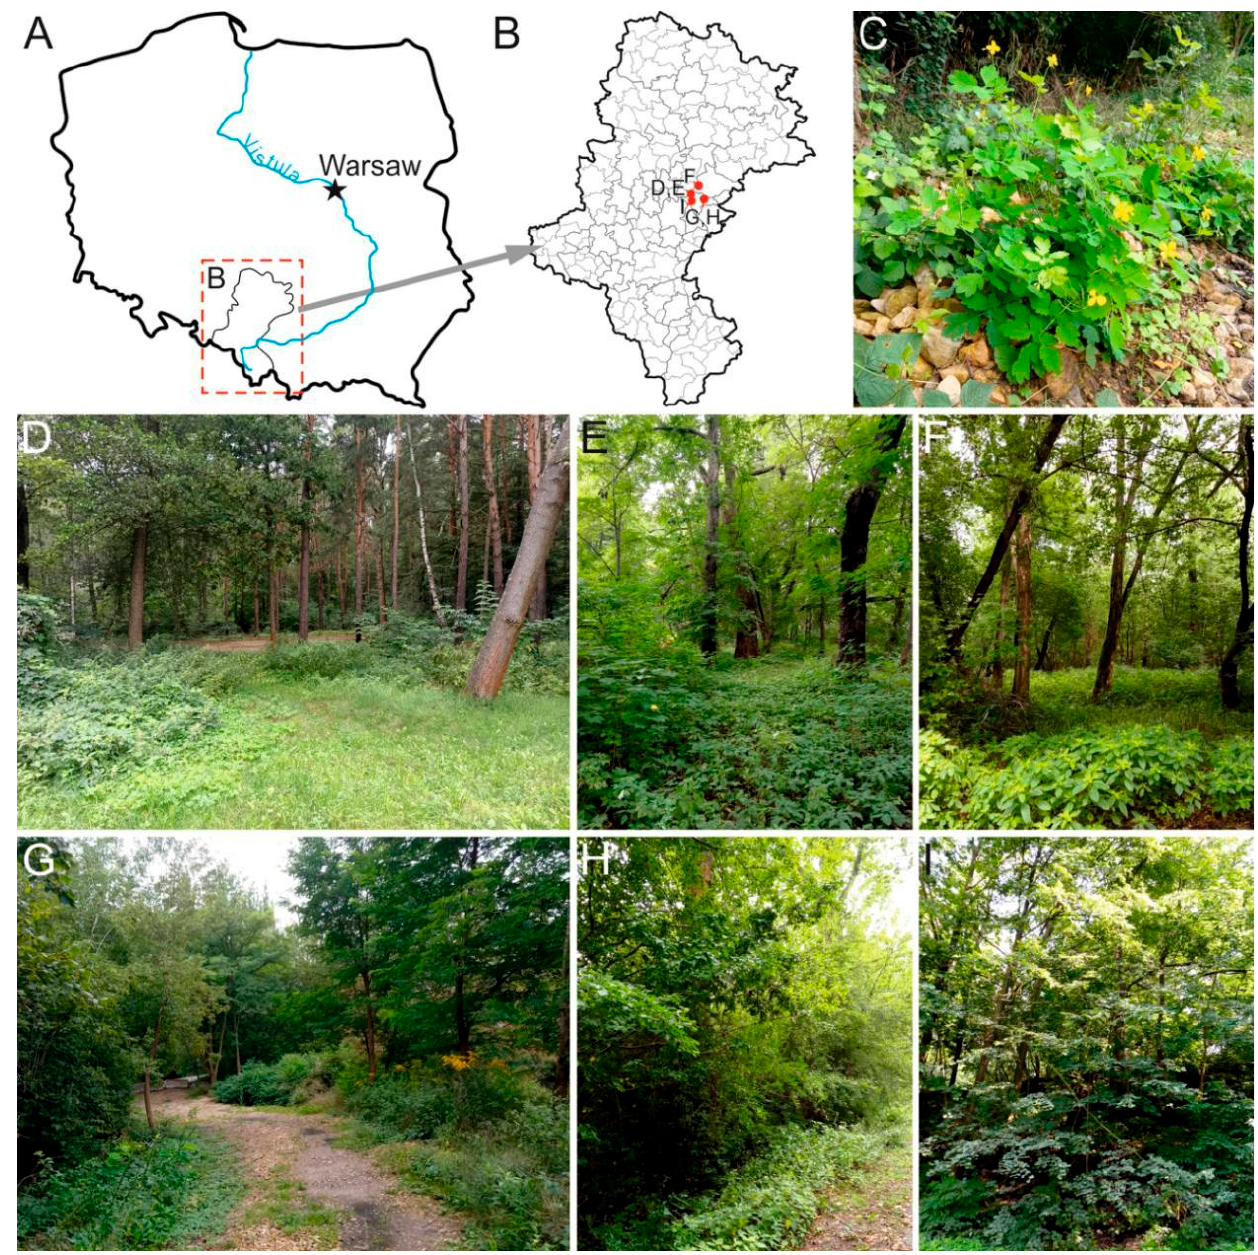
Figure 1. Sampling locations. ( A ) Silesian voivodship on the background of the contour map of Poland; ( B ) sampling sites in the background of the contour map of the Silesian voivodeship; ( C ) photo of Ch. majus ; ( D – I ) photos of sampling sites from Schöen Park (PSchoe-2), allotment gardens near Przemsza river (APrzem-1), Zielona Park (PZiel-3), Le´sna Park (PLes-4, PLes-5), and Sielec Park (PSiel-6),